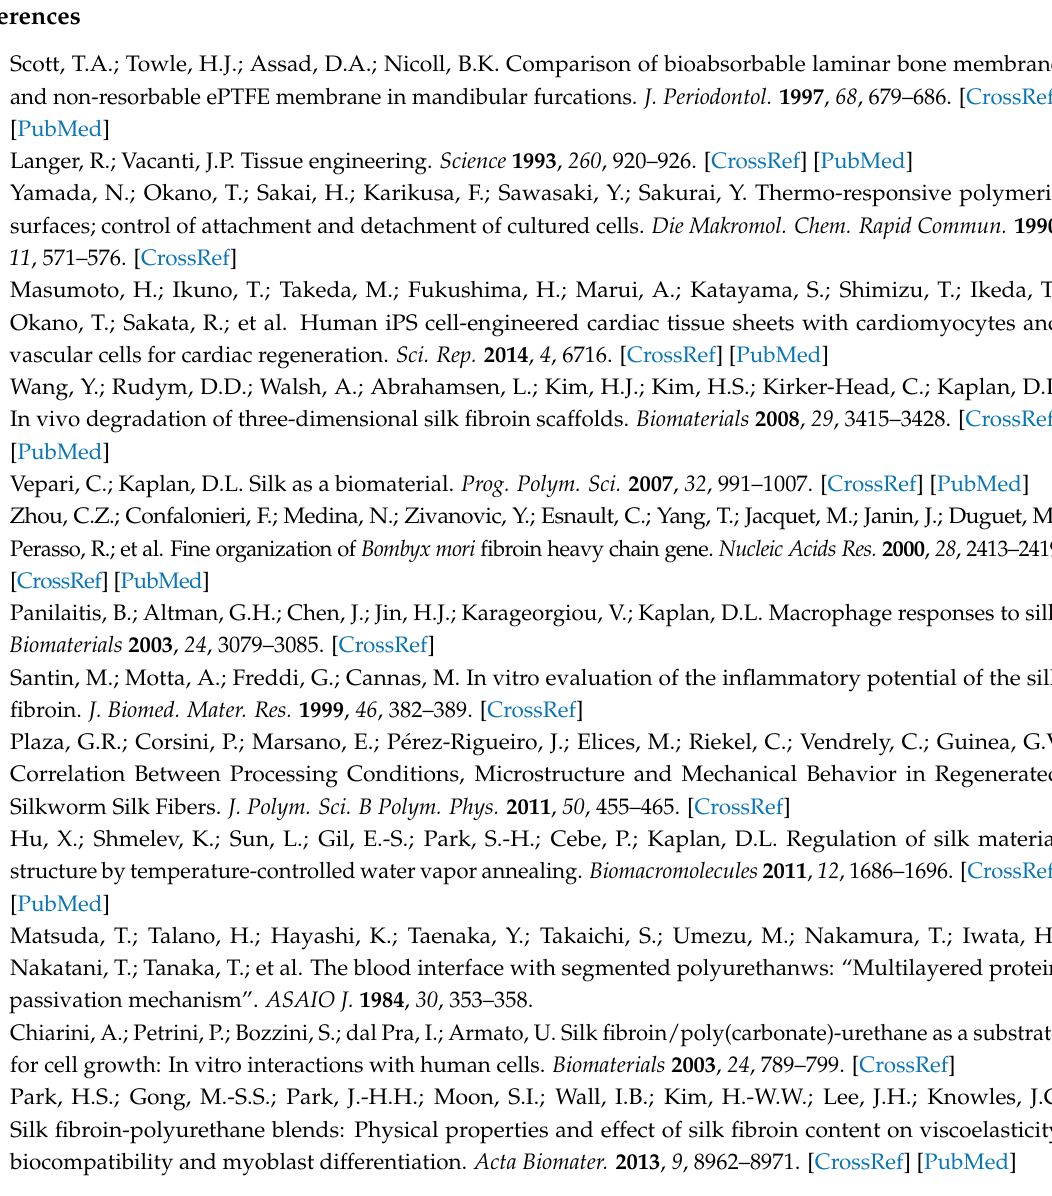
Table S1. Electrospininng conditions for each